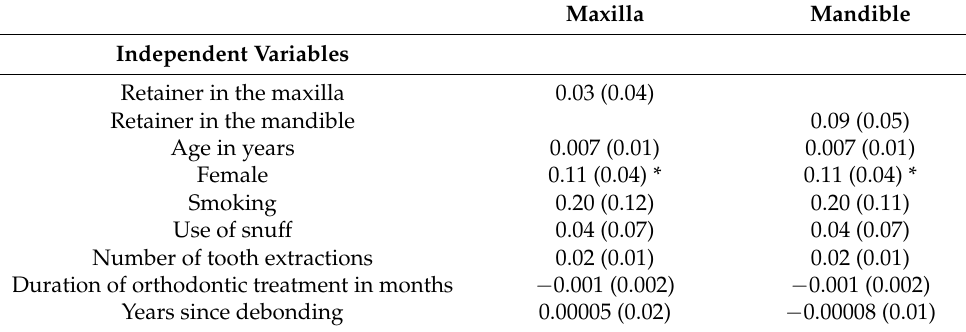
Table 6. Predictors of patient-reported gingival recession.